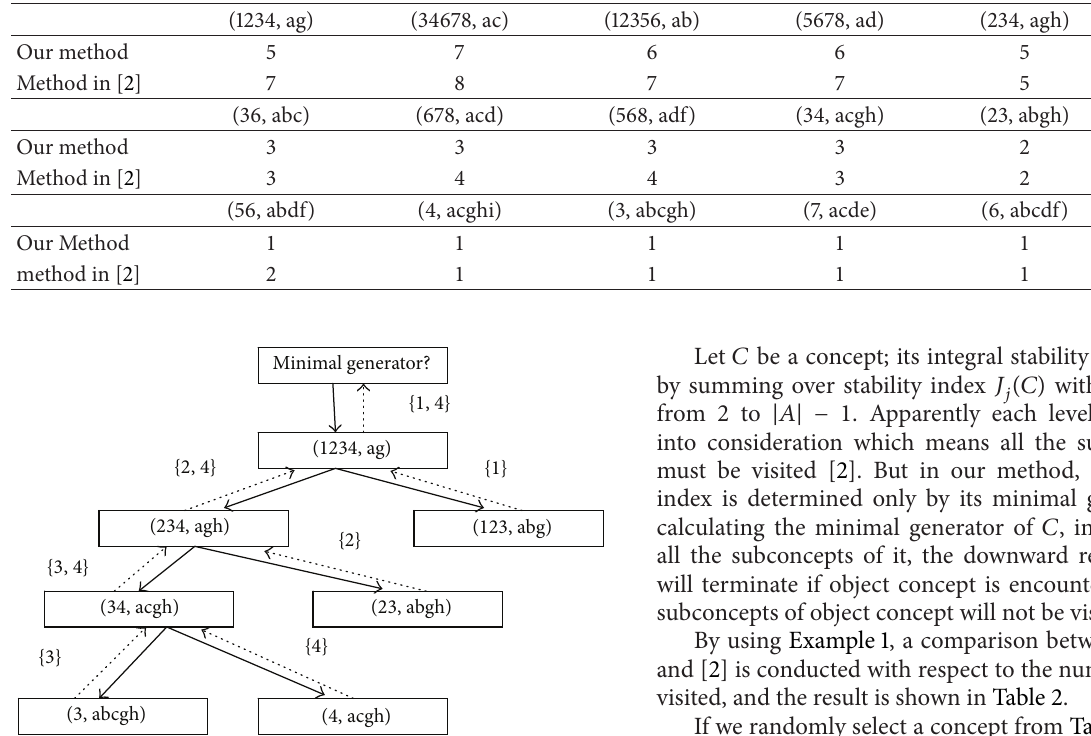
Figure 2: Minimal generator calculation process. (The solid arc represents downward recursive call, and the set besides the dotted upward arc represents the return